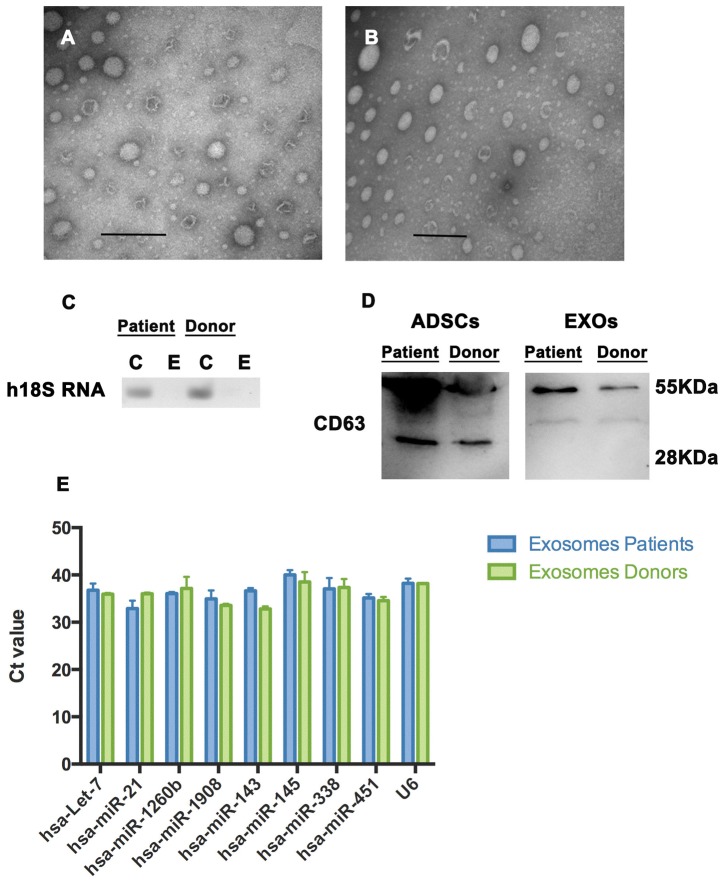
ADSC-derived Exosome isolation and characterization from cancer patients and non-oncogenic participants.Isolated microvesicles transmission electron microscopy images from cancer patients (A) and non-oncogenic participants (B) are shown. Lack of 18S RNA in EXOs was evidenced by RT-PCR analysis, total RNA from ADSCs was used as control (C). CD63 exosome marker evidenced by western blot analysis of total protein extracts prepared from microvesicle fractions and cell lysates (D). miRNA levels were determined by qRT-PCR analysis of total RNA prepared from EXOs; using U6 as an internal control (E).